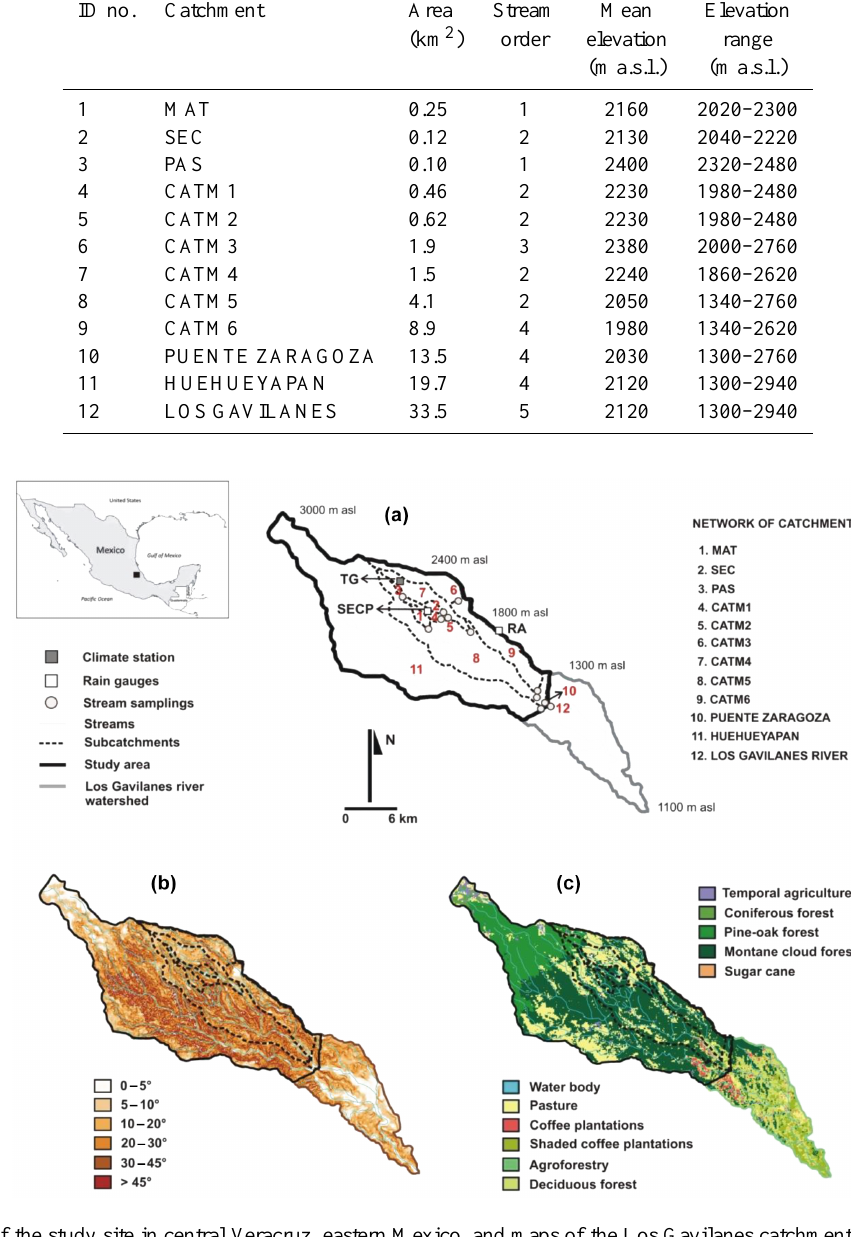
nual mean daily temperature is 19 ◦ C. Corresponding